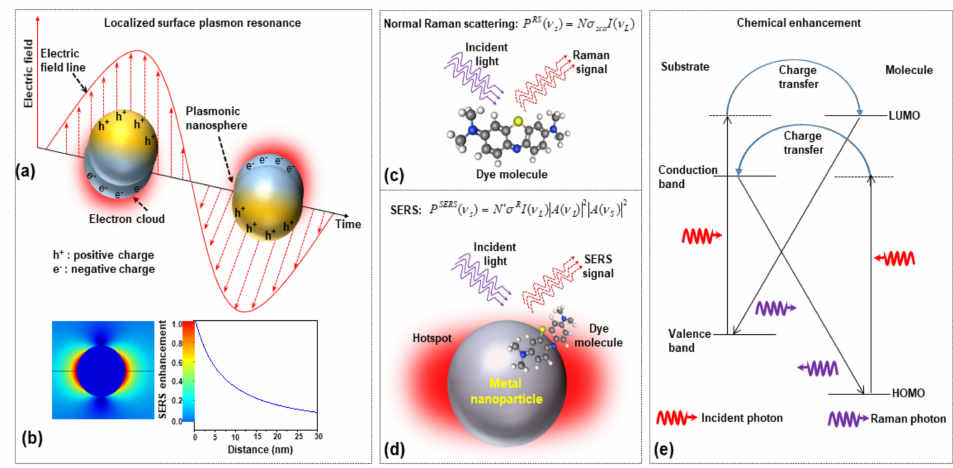
Figure 1. The schematics of ( a ) localized surface plasmon resonances (LSPR) from plasmonic nanopar- ticles, ( b ) numerical simulation of the electric field distribution of isolated AuNP and its dependence of SERS enhancement on the distance from nanoparticle surfaces, ( c ) the normal Raman scatting process, ( d ) two-step EM enhancement mechanism in SERS, and ( e ) chemical enhancement in SERS (HOMO: highest occupied molecular orbital and LUMO: lowest unoccupied molecular